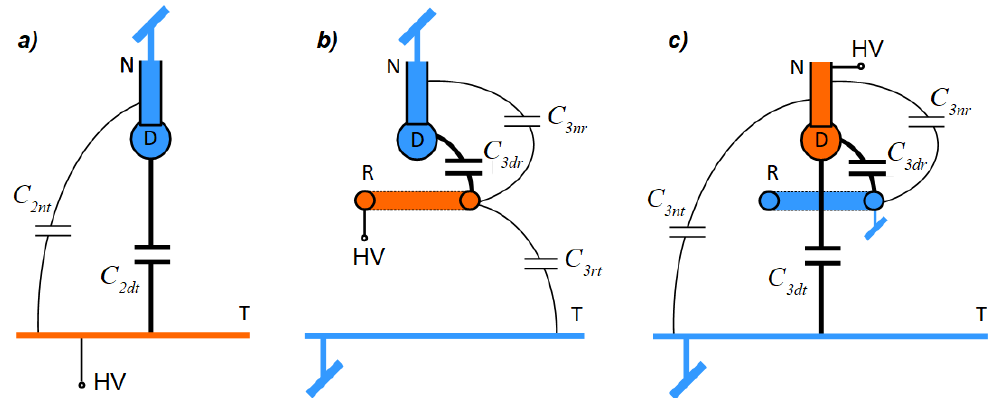
Figure 3. Effective capacitance distribution: ( a ) induction method in a 2-electrode system, ( b ) induction method in a 3-electrode system, and ( c ) conduction method in a 3-electrode system. Capacitances associated directly with droplets are marked with a thicker line.